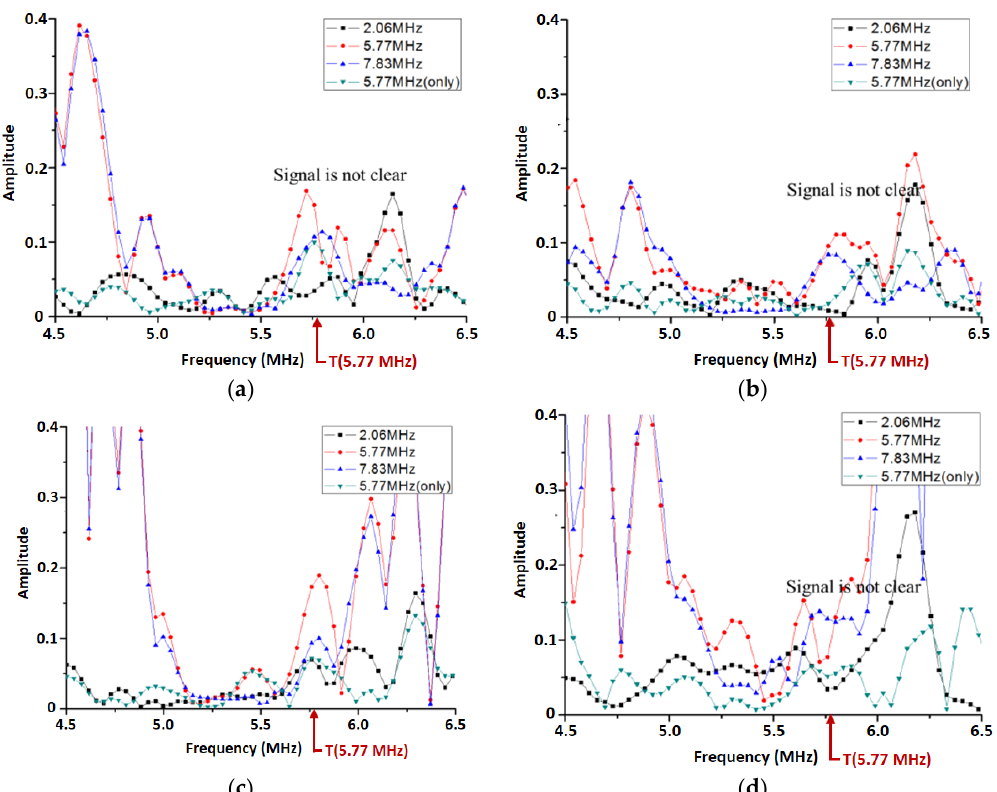
Figure 12. Frequency domain analysis results: ( a ) S1 mode, forward direction; ( b ) S1 mode, inverse direction; ( c ) A1 mode, forward direction; ( d ) A1 mode, inverse direction.